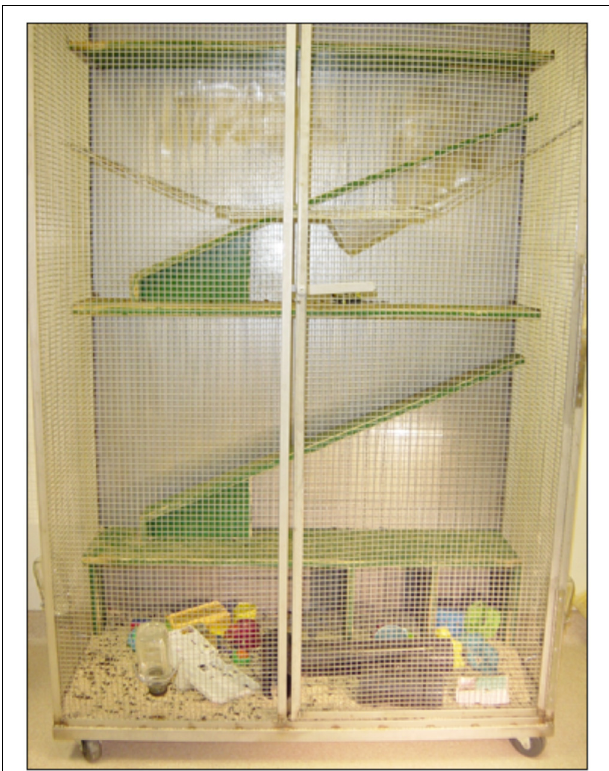
FIGURE 1 | Complex housing for rats (Condominiums). The hardware cloth construction and a series of runways and swings allowed exploration of the condominiums in all dimensions. PVC pipes provided dark shelter for inhabitants. A variety of hard plastic toys were placed on the condo floor and were changes weekly to provide additional